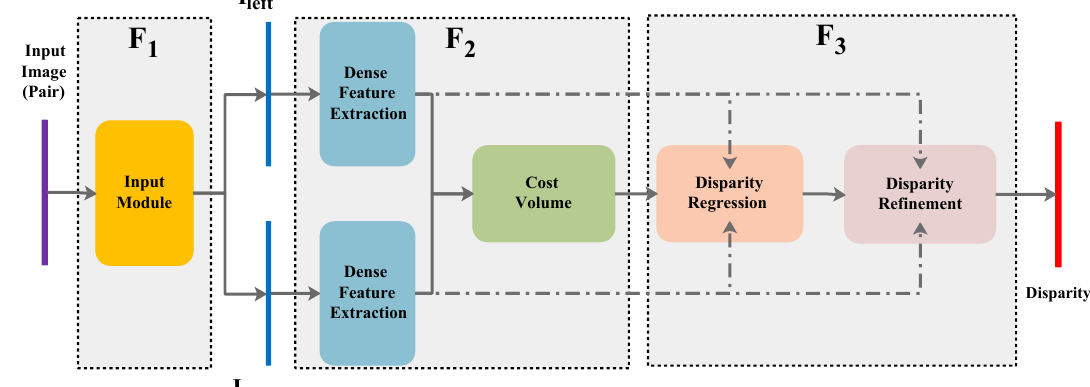
Figure 1. Frameworks of the proposed method.